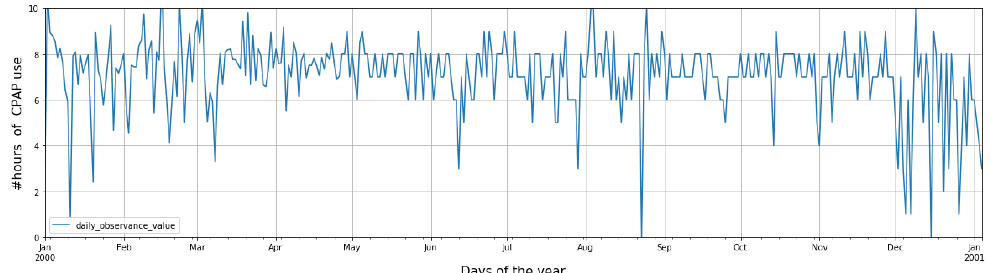
Figure 1. Sample of a CPAP use time series obtained by means of telemonitoring. One-year-long times series of CPAP use (#hours) of a real anonymized patient. The number of hours ranges from 0 (the patient did not use, or was not able to use the CPAP) up to 10 h of